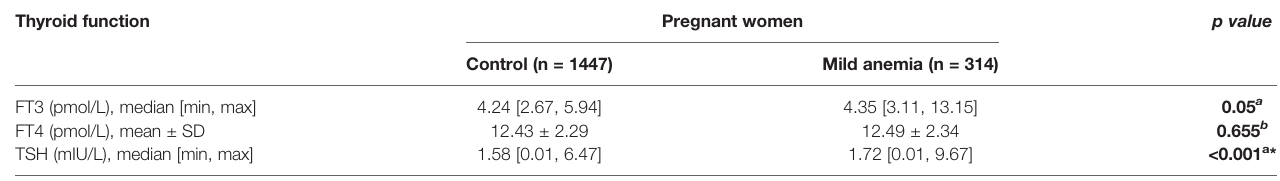
TABLE 1 | Comparison of thyroid functions between pregnant women with mild anemia and control group. Thyroid